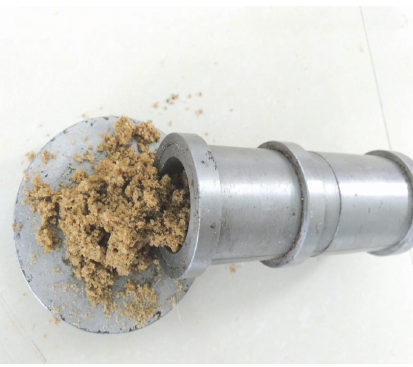
Figure 2: Sample of unreinforced sand. Figure 3: Sample of fiber reinforced sand.